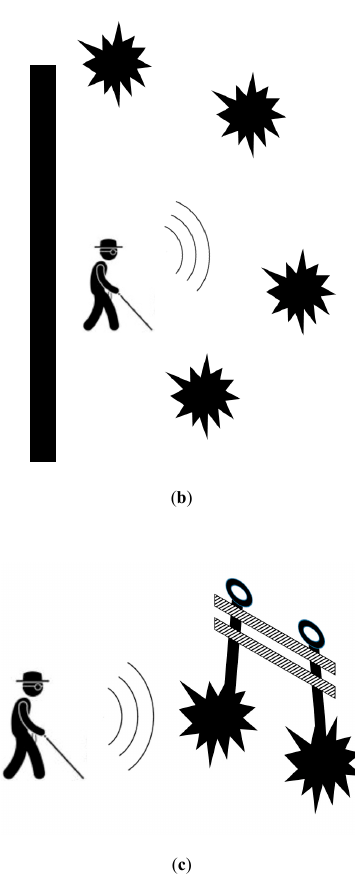
Figure 2. Test set-up with ( a ) aligned obstacles, ( b ) obstacles shaped as a cage, and ( c ) obstacles at chest level.